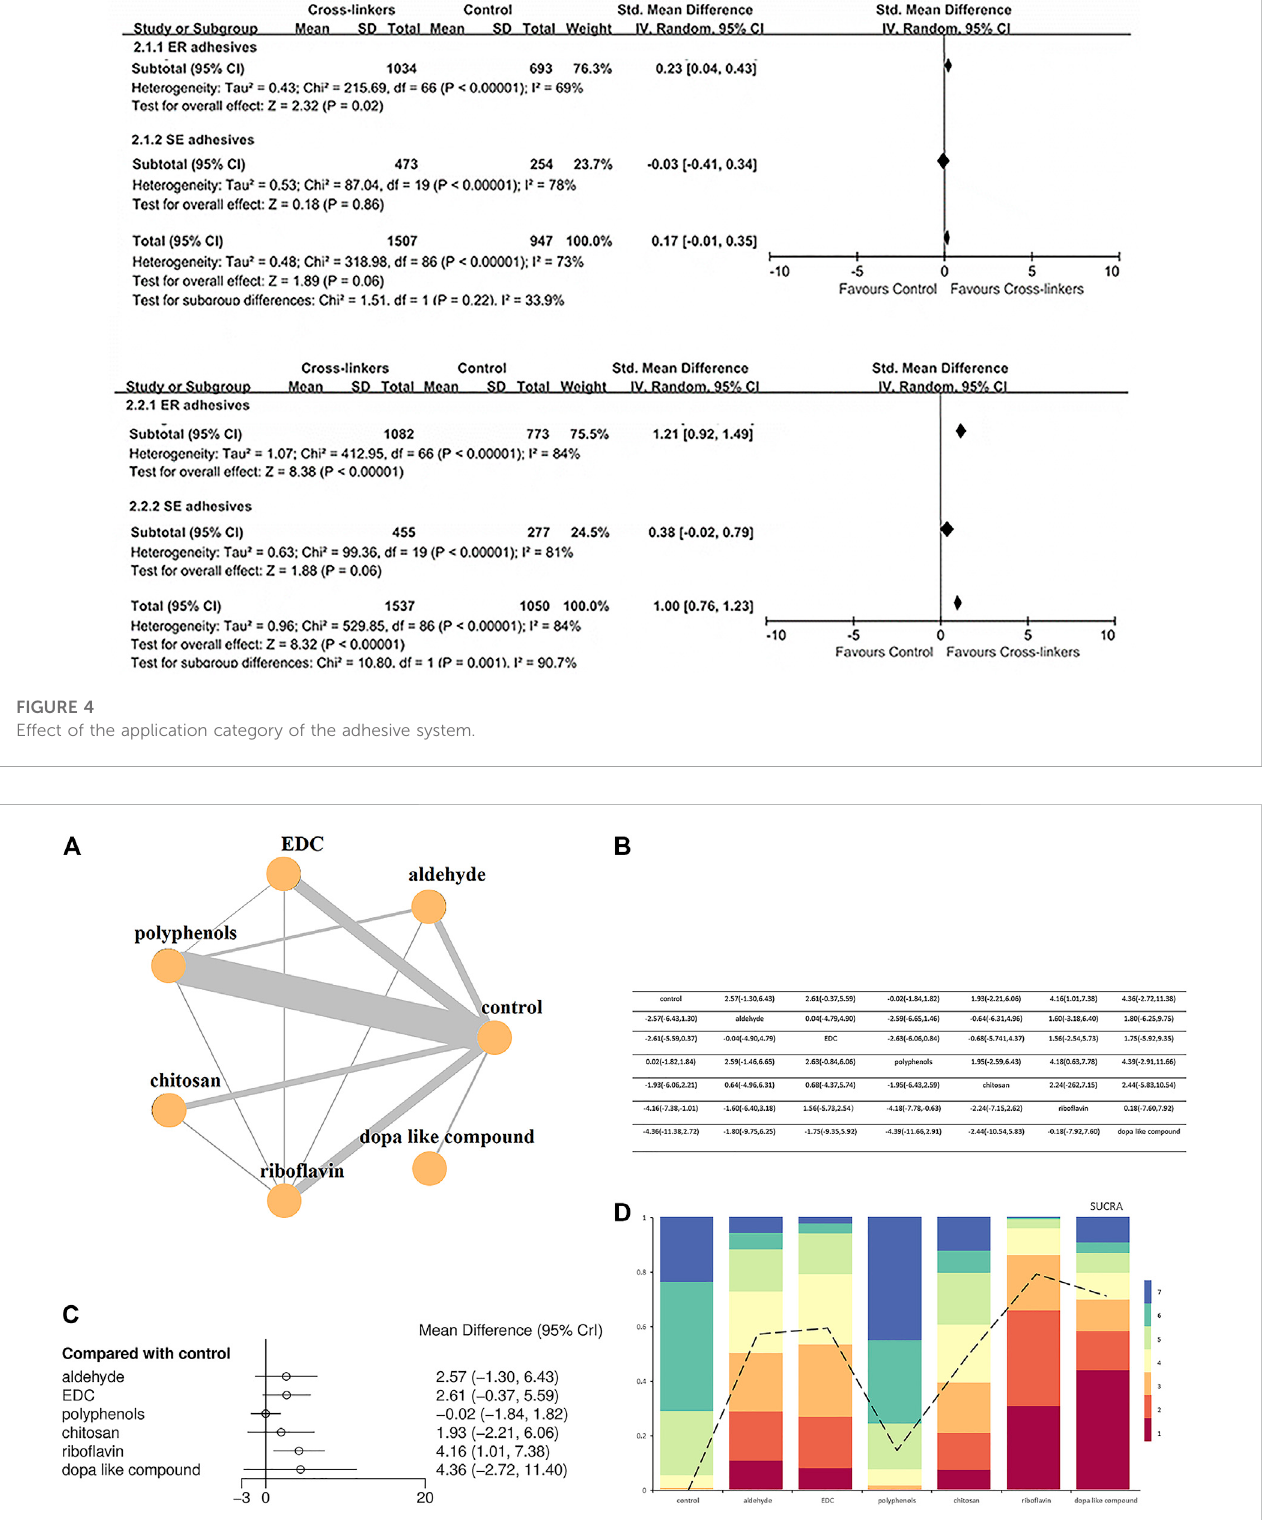
FIGURE 5 Network meta-analysis comparing bond strengths among seven group arms. (A) Network plot where each node indicates a direct comparison (control, aldehyde, EDC,polyphenols,chitosan,ribo fl avinanddopa likecompound) withthethickness ofconnecting linesbetweennodesrepresenting thenumberof studies compared. (B) League table showing Bayesian comparisons for all groups: this table shows the results for all group pairs in the upper (direct comparison) andlower(indirect comparison) triangles,but thecomparisons havebeen switched; Fortheleading diagonal above andbelow, theresultis the grouping at the top of the same column versus the grouping to the left of the same row. (C) Bayesian random effect consistency model forest plot of the pooled effects estimates of bond strengths expressed in mean difference (MD) and respective 95% credible intervals (95% CrI) for different adhesive groups compared with the control group. (D) Cumulative ranks and